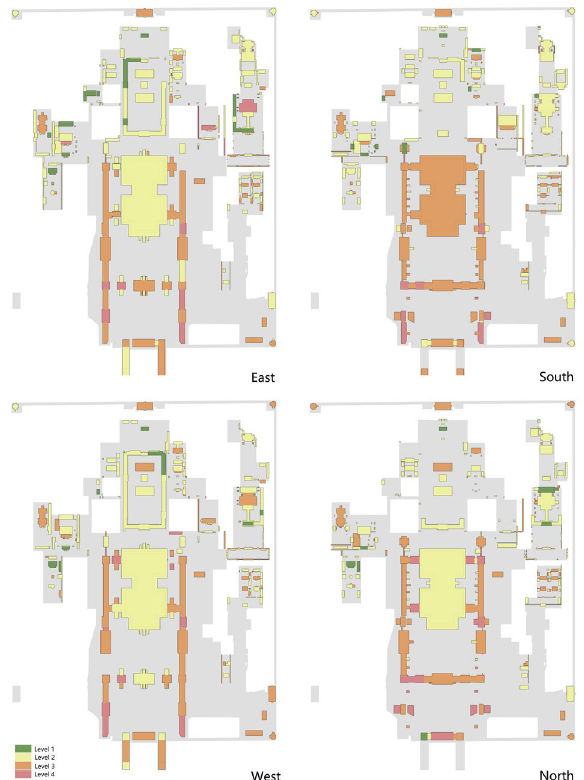
Figure 9. Overall deterioration conditions on 4 directions.